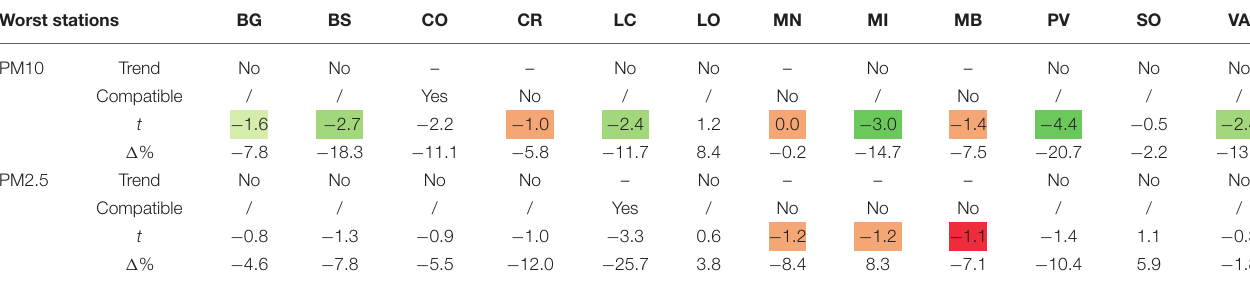
TABLE 4 | Comparison between the average concentrations of PM10 and PM2.5 in the periods 9 March–18 May 2016–2019 and 2020.